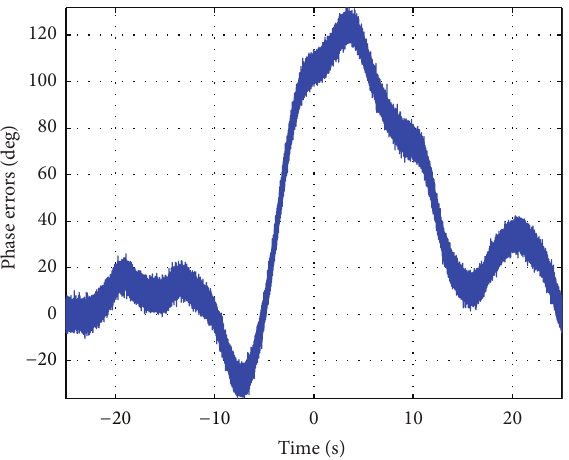
Figure 6: Prediction of phase errors via the dedicated synchroniza- tion